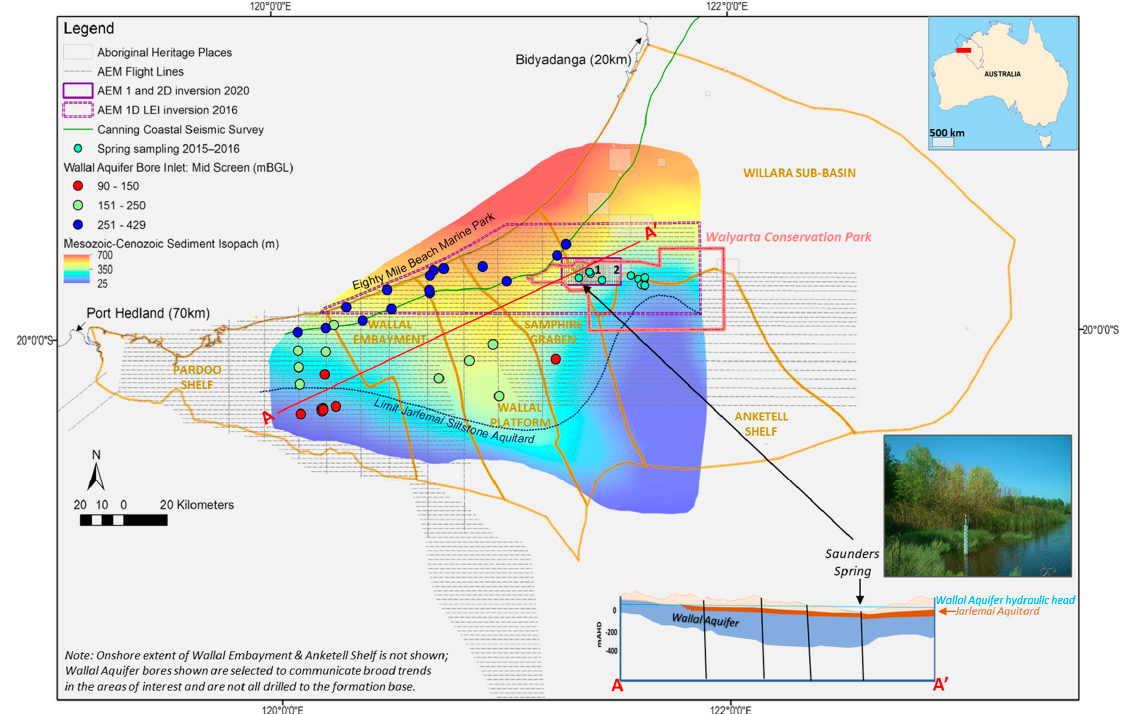
Figure 1. Location of Walyarta Conservation Park study area showing tectonic elements of the West Canning Basin (WCB) and the broad-scale distribution of the combined Mesozoic to Cenozoic sediments that host the Wallal Sandstone aquifer. Note: Aboriginal Heritage Places marked 1 and 2 are registered sites 14478 and 14479 (Aboriginal Heritage Places (DPLH- 001)–Datasets, Available online: https://www.dplh.wa.gov.au/information-and-services/aboriginal-heritage/aboriginal- heritage-search, accessed on 24 March 2021); the inset map of Australia has the full extent of the Canning Basin, with the WCB in red.